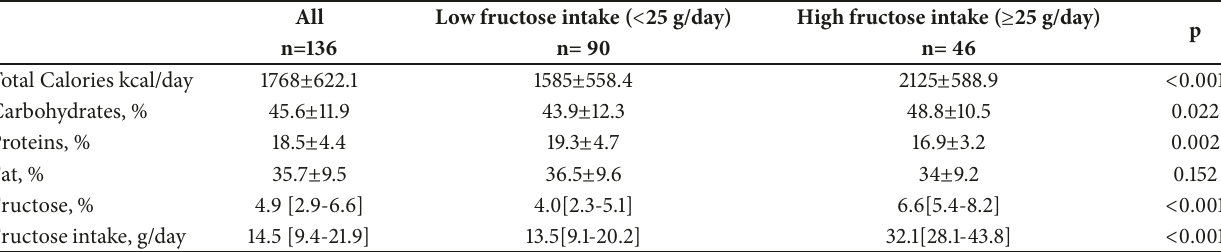
Table 2: Calorie and fructose intake in low and high fructose intake